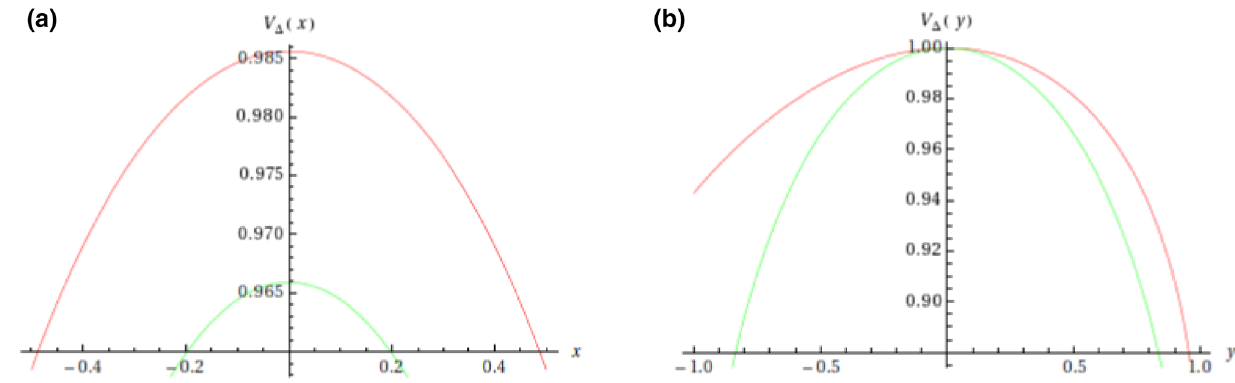
Fig. 4 The l.h.s. panel a the (cid:2) (red) and Y-string (green) potentials in the right-angled triangle configurations. r.h.s. panel b The (cid:2) (red) and Y-string (green) potentials in the isosceles triangle